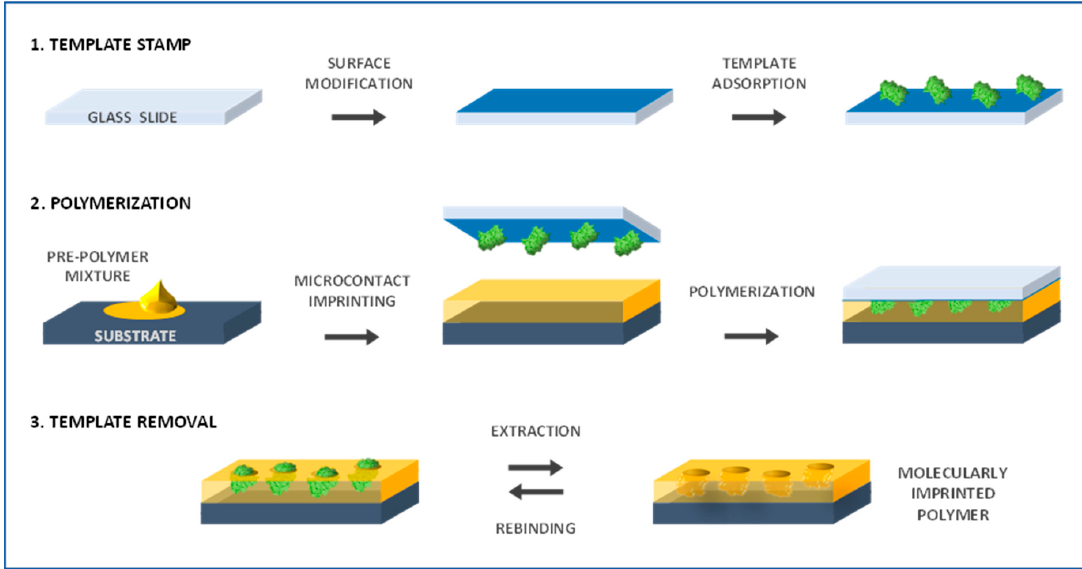
Figure 2. Schematic representation of microcontact imprinted polymer fabrication.